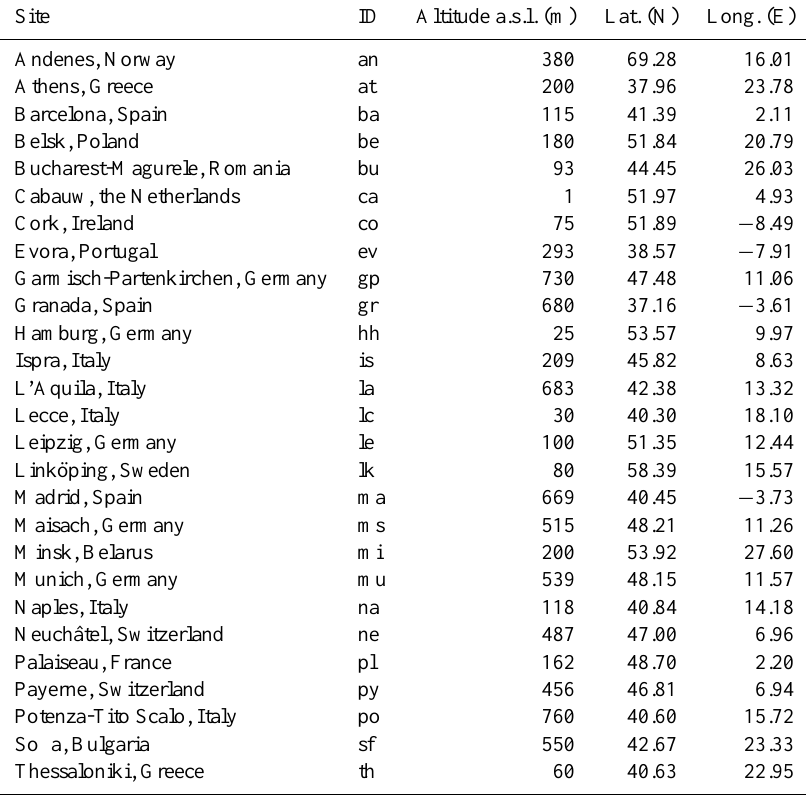
Table 1. Locations of EARLINET lidar stations, corresponding ID code, altitude, and geographical